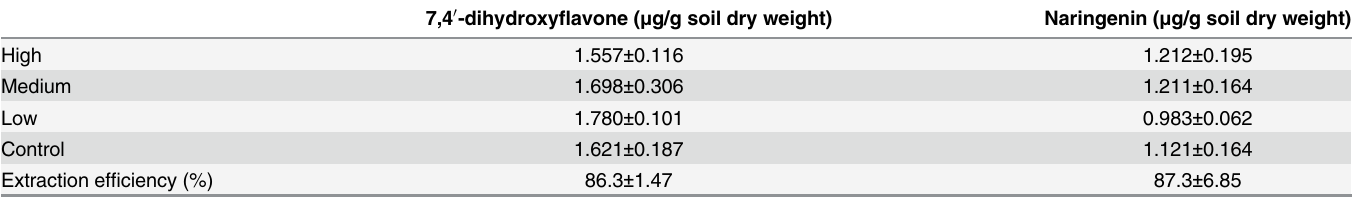
Table 1. Soil ATP concentrations, and estimated ATP extraction